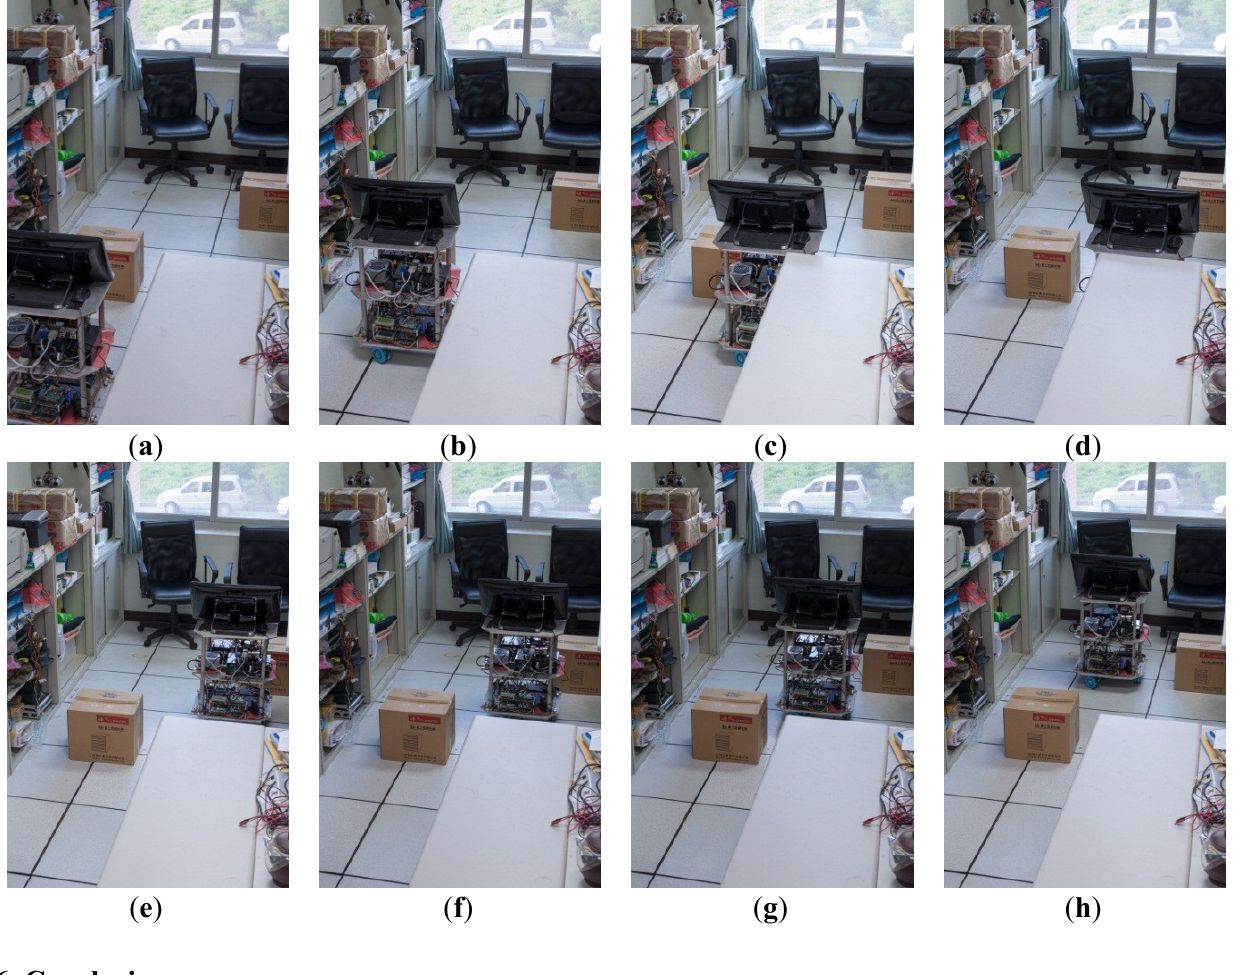
Figure 16. A set of obstacle-avoidance experiments. ( a – d ) Actual experimental pictures of the robot pass the first obstacle and ( e – h ) actual experimental pictures of the robot pass the second